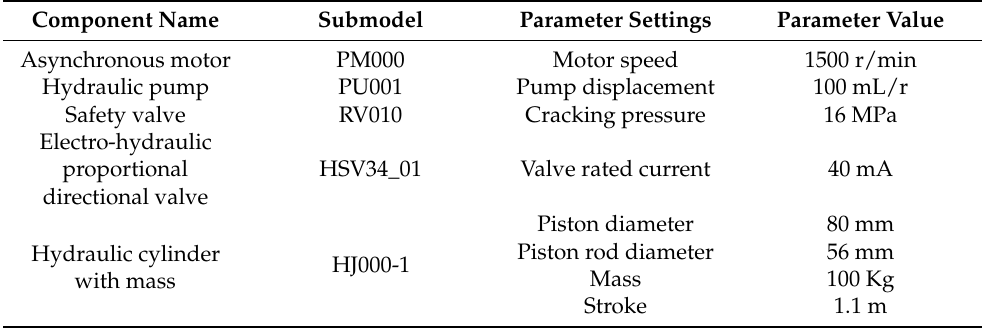
Table 2. Parameter settings of the main components of the propulsion system model.